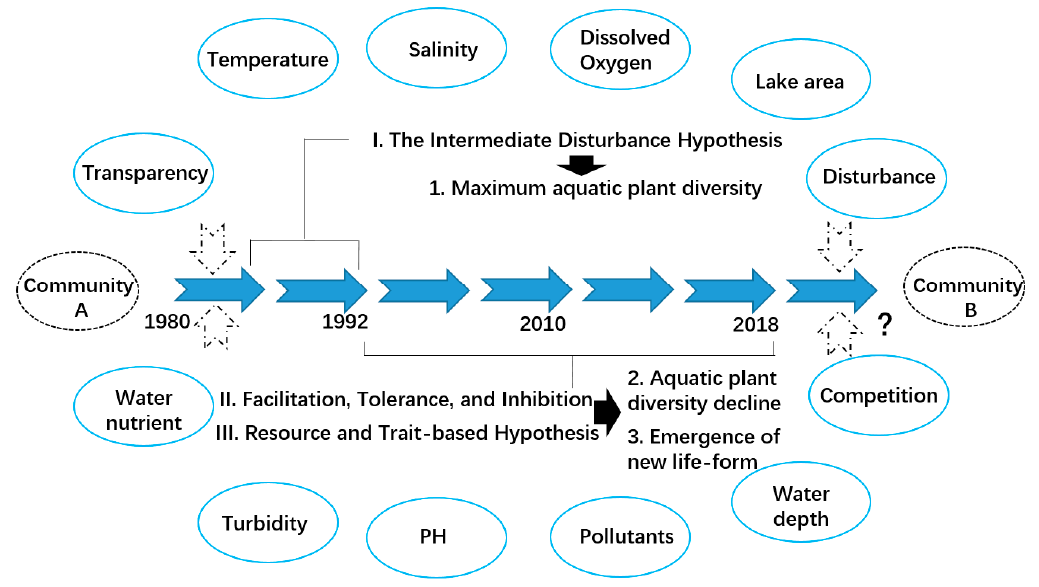
Figure 8. A conceptual model illustrating the di ff erent stages of aquatic vegetation succession in Chenghai Lake.